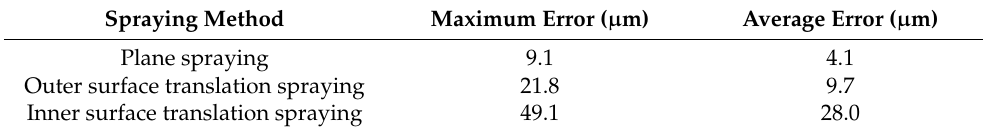
Table 2. Comparison of film